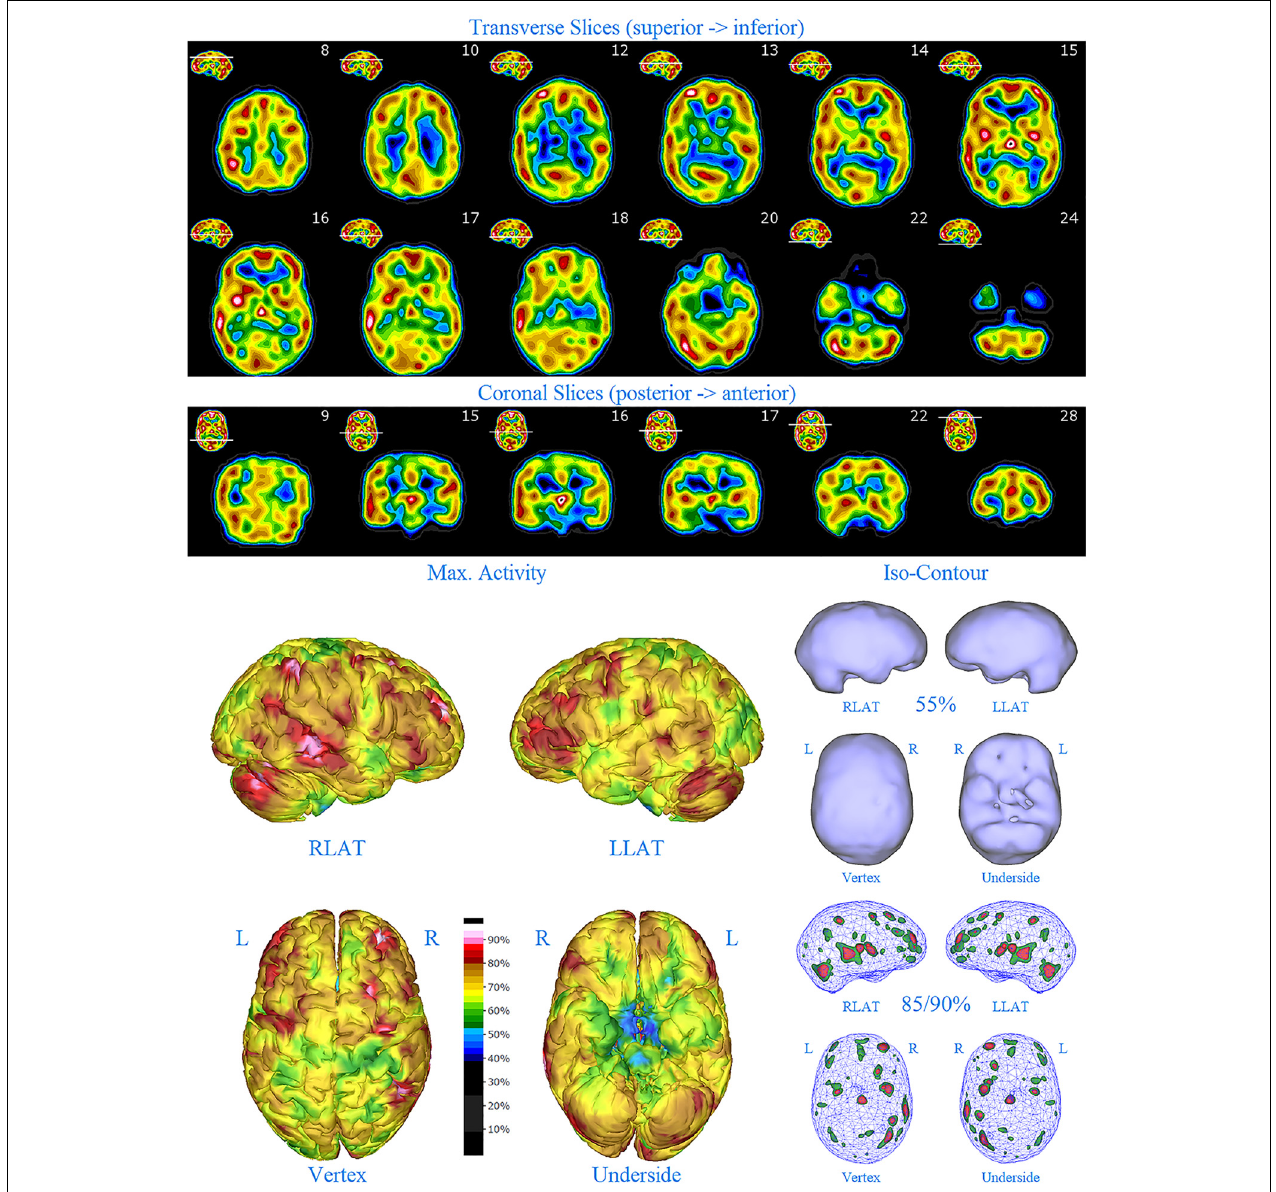
FIGURE 7 | Second perfusion SPECT scan of Patient D. Arrangement, color scales, and views are identical to Figure 1 . Anatomical structures such as the thalamus are positioned similarly to the scan shown in Figure 2 . Labeling was eliminated to avoid obscuring the scan details. Perfusion of the thalamus is intensely increased and asymmetrical. Areas of increased perfusion in the cerebral cortices are considerably less